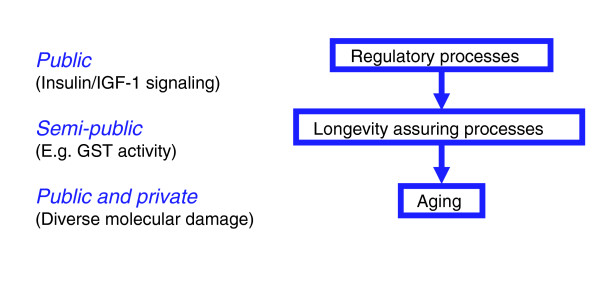
Different determinants of longevity may be public, semi-public or private. Our results suggest that public regulators of lifespan regulate semi-public mechanisms of longevity assurance, which may in turn act on a combination of private and public mechanisms of aging. The semi-public character of longevity assurance processes is reflected by the IIS-regulated gene classes. Several are linked to detoxification (such as the GSTs), and are the results of copious lineage-specific expansions.